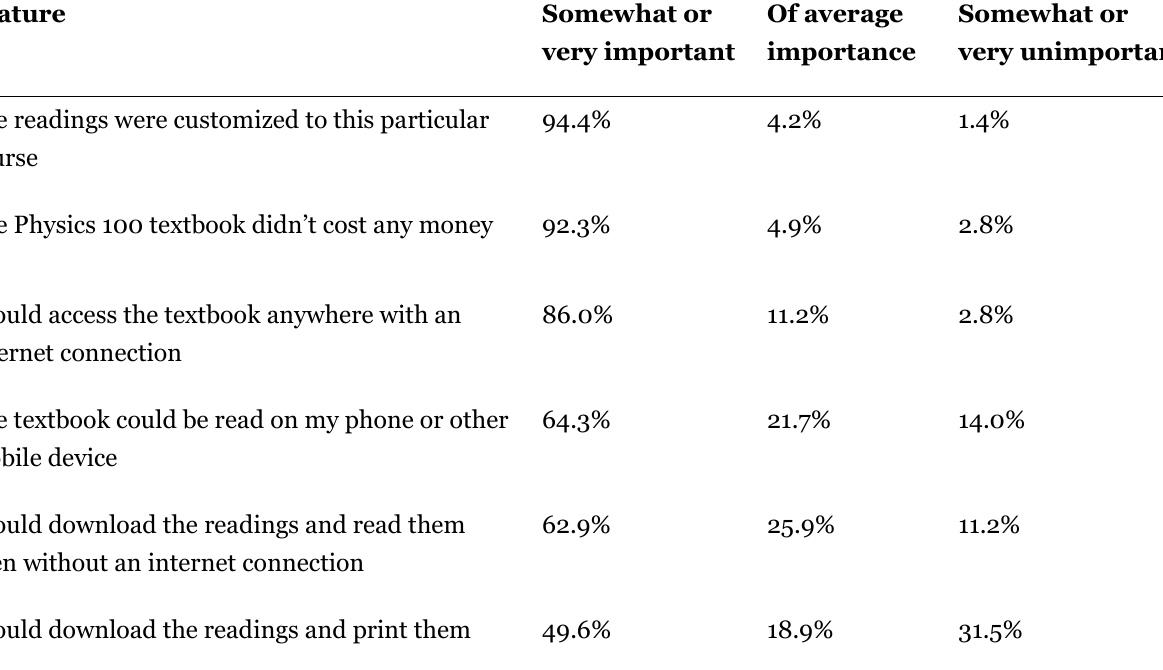
Data for Figure 3: How Important Students Found Various Features of the Physics 100